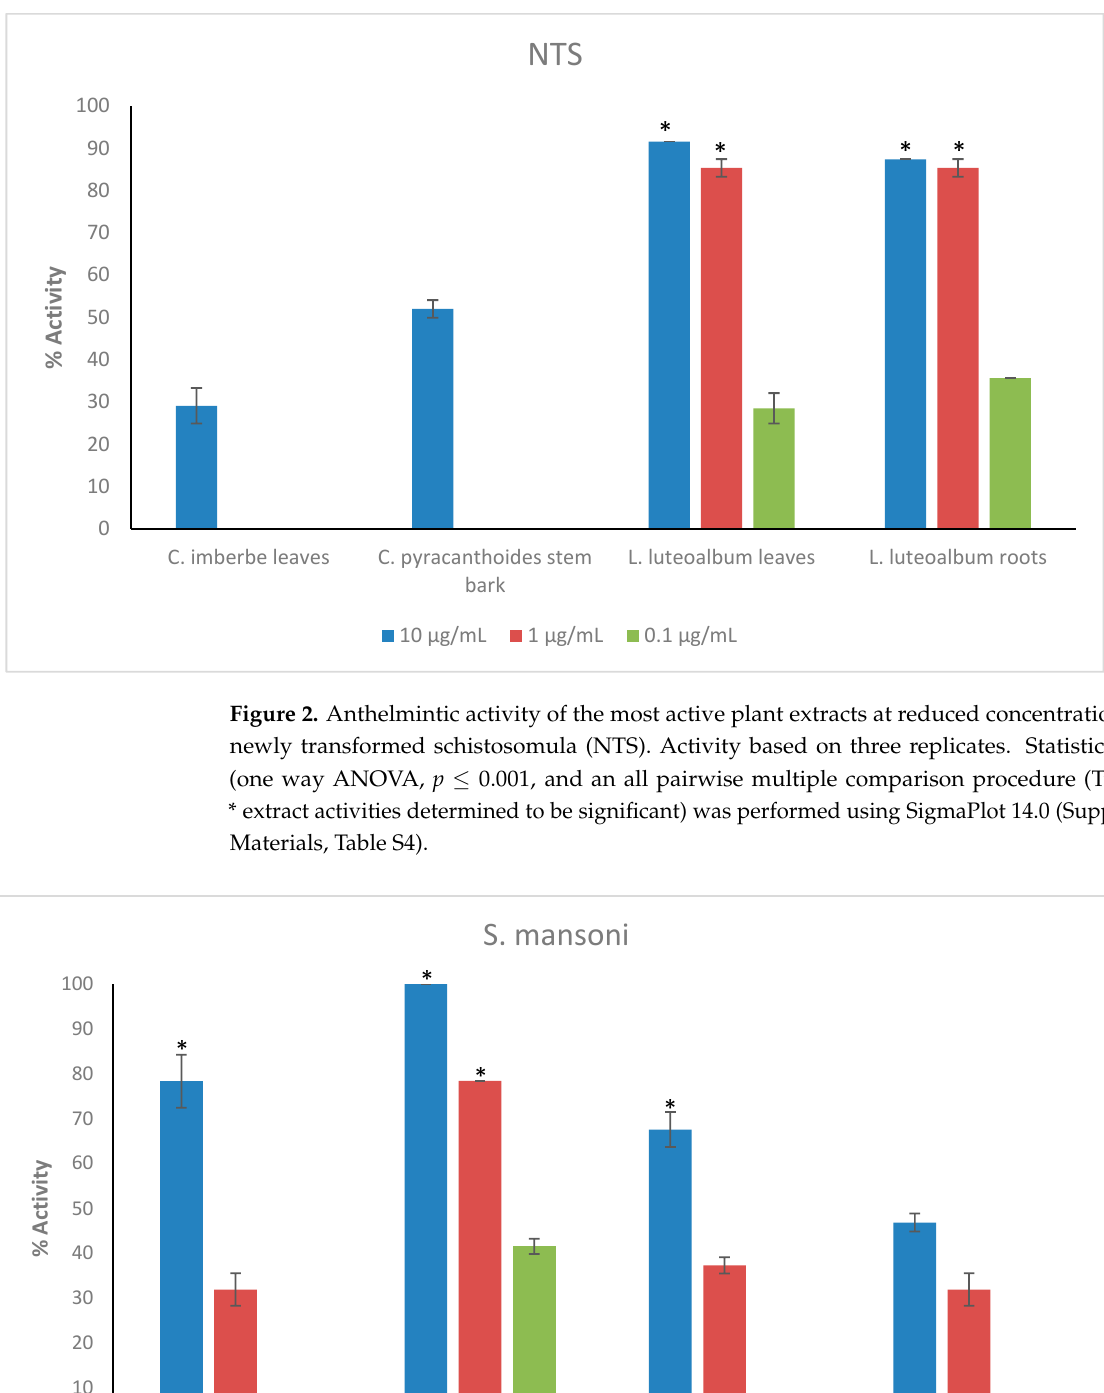
Figure 1. Anthelmintic activity of the plant extracts against the parasitic organisms. Activity based on three replicates. Statistical analysis (one way ANOVA, p ≤ 0.001, and an all pairwise multiple comparison procedure (Tukey Test), * extract activities determined to be significant) was performed using SigmaPlot 14.0 (Supplementary Materials, Table S3).